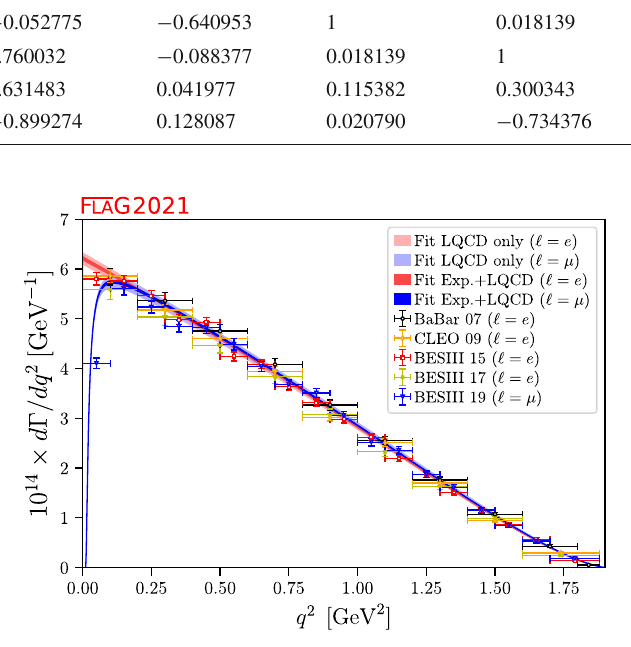
Fig. 25 The D → K (cid:6)ν differential decay rates experiment error, in order to allow for a direct comparison, and dropped the estimated systematic uncertainties due to electroweak and electromagnetic corrections also provided in HPQCD 21A). This is due to the fact that HPQCD 21A has applied the structure-independent electroweak correction factor η EW = 1 . 009 ( 2 ) in their analysis, which we are not doing for consistency with other determinations in this review; if we had applied the same procedure, our final result would be | = 0 . 9628 ( 68 ) | V cs